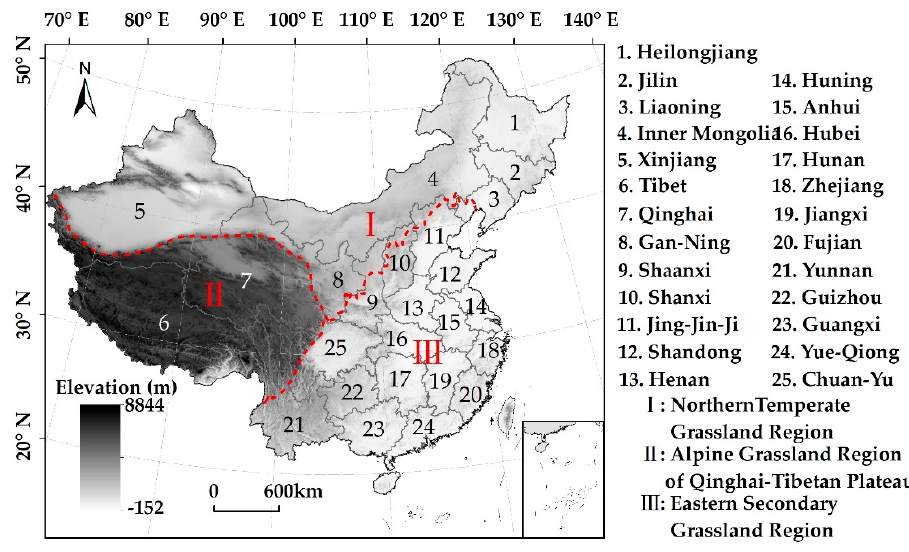
Figure 1. Location of the study area.